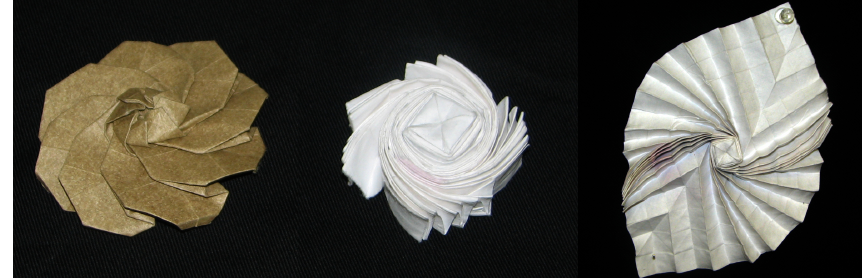
Figure 1. Example of an origami structure (left) and flasher hat mechanism in its fabricated (middle) and deployed form (right). Fig. 1. Example of an origami structure (left) and flasher hat mech- anism in its fabricated (middle) and deployed form (right). between motion and structure of origami, and can help in understanding how to predict complex motion and develop corresponding